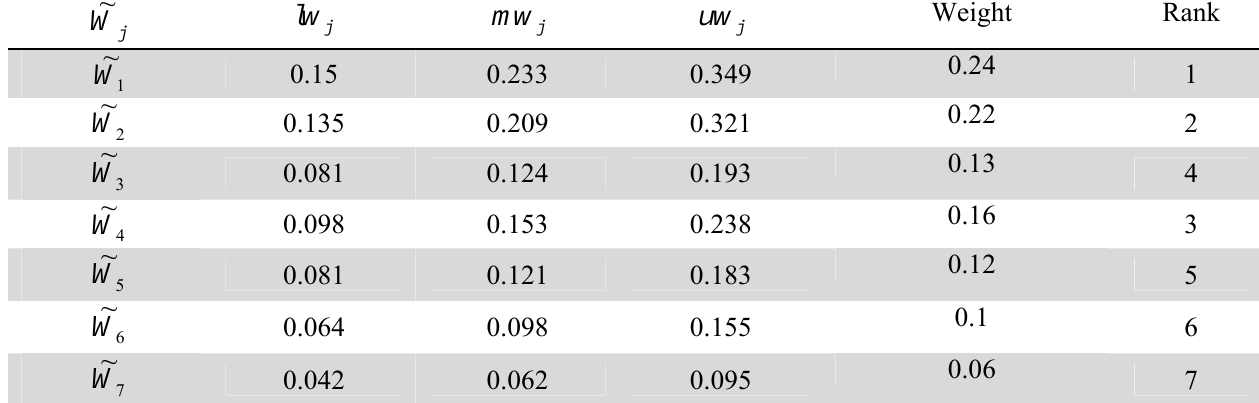
The summary of ranking seven criteria based on fuzzy Delphi for green supply chain criteria